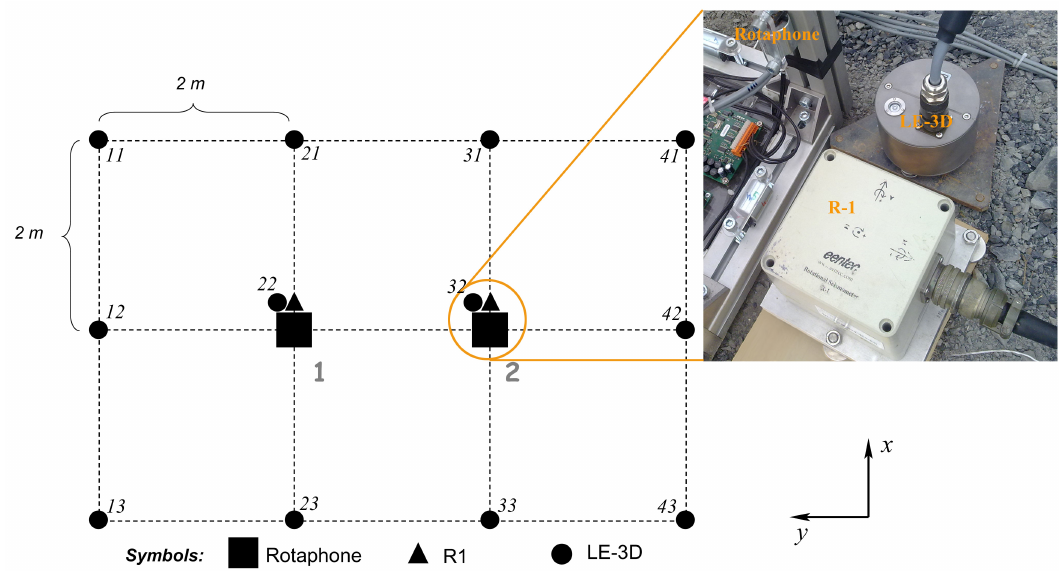
Figure 2. The comparative experiment — basic instrument lay-out. Two-digit numbers code LE-3DLite velocigraphs. Grey numbers mark two central grid points. Inset: one of the Eentec R-1 rotational sensors in the experimental setting together with the Lennartz LE-3DLite translational sensor and the Rotaphone sensor